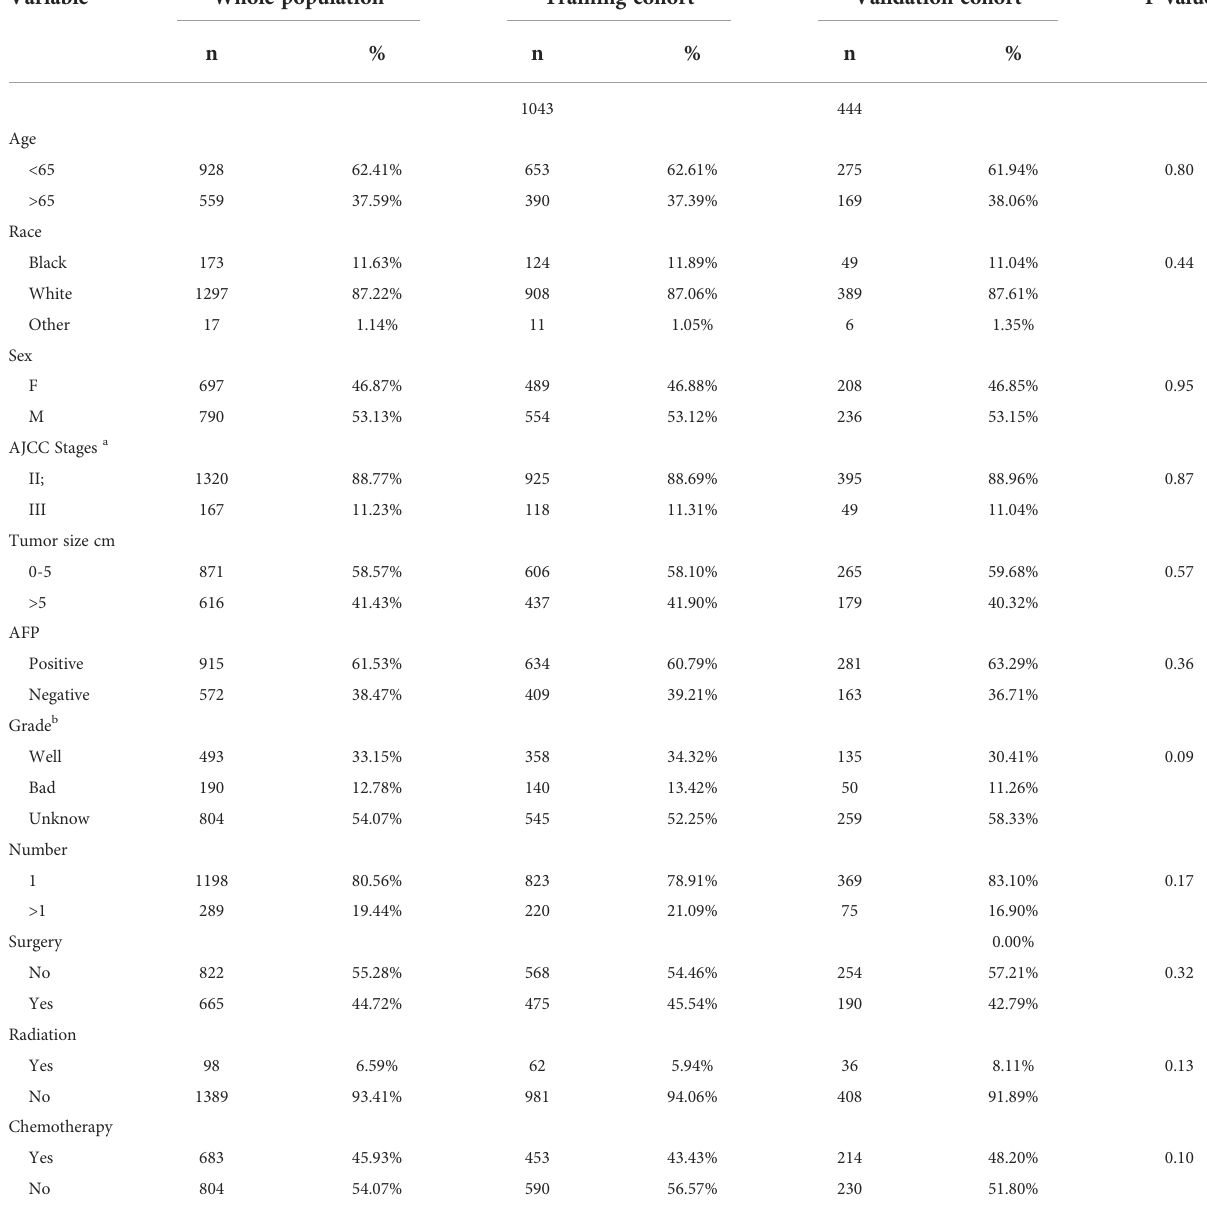
TABLE 1 Demographics and clinical and pathology characteristics of the patients with hepatocellular carcinoma and microvascular in fi ltration. Variable Whole